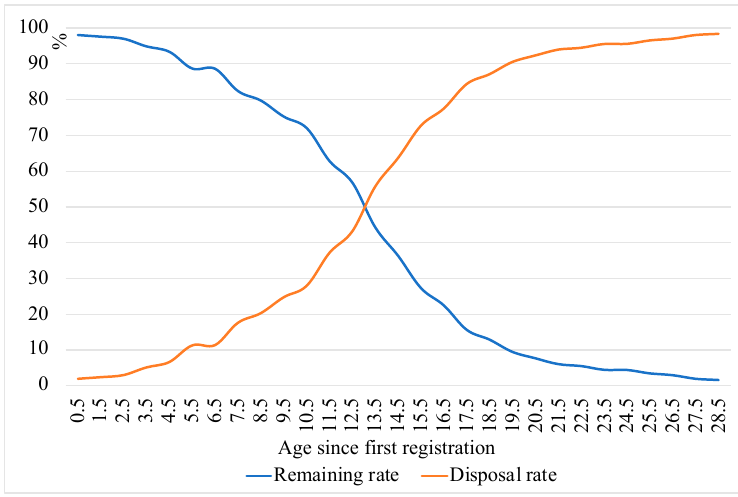
Figure 2. Deregistration rate of vehicle in Japan. Source: Figure made by the author based on Automobile Inspection & Registration Information Association’s data [20].